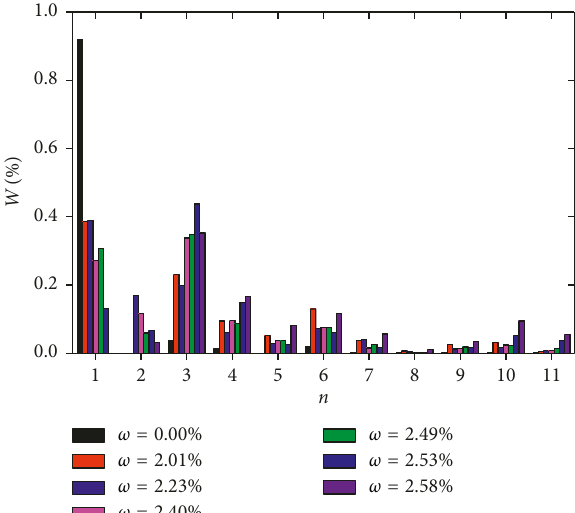
Figure 8: Percent of the mass of fragments with different grain sizes to the total mass of the sample.